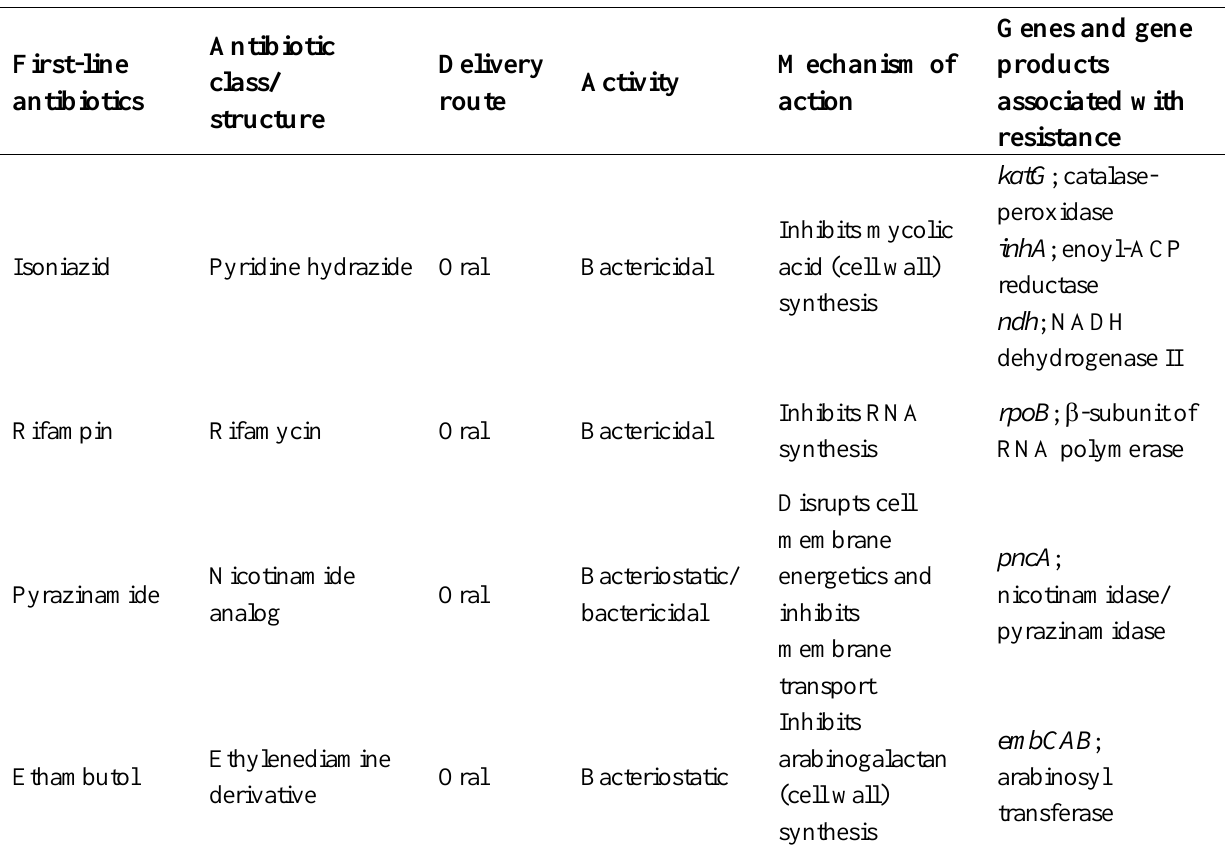
Table 2. First-line anti-TB drugs